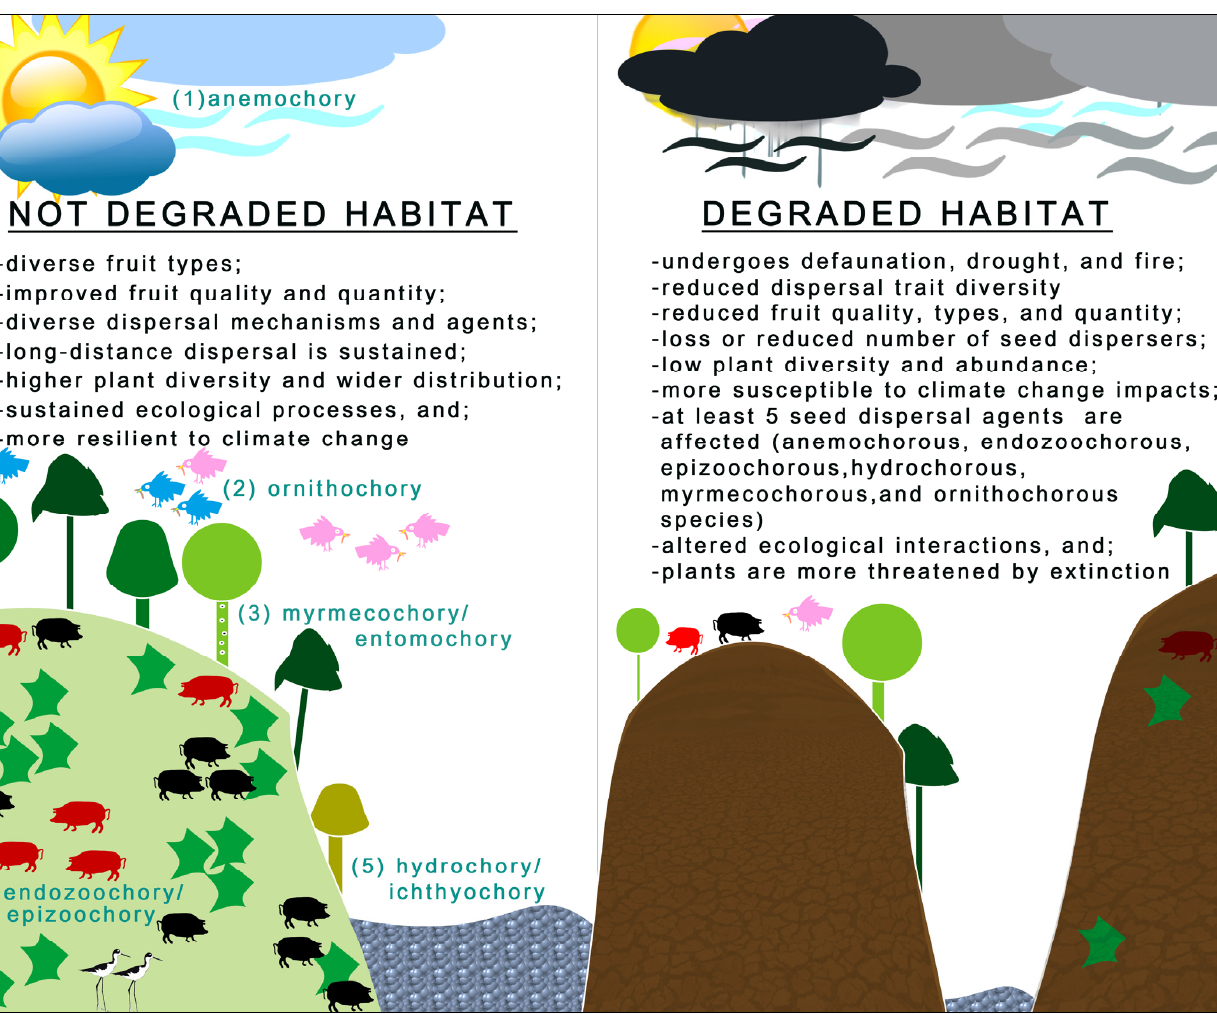
Figure 4. Contrasting seed dispersal modes and agents between not degraded and degraded habi- tats.